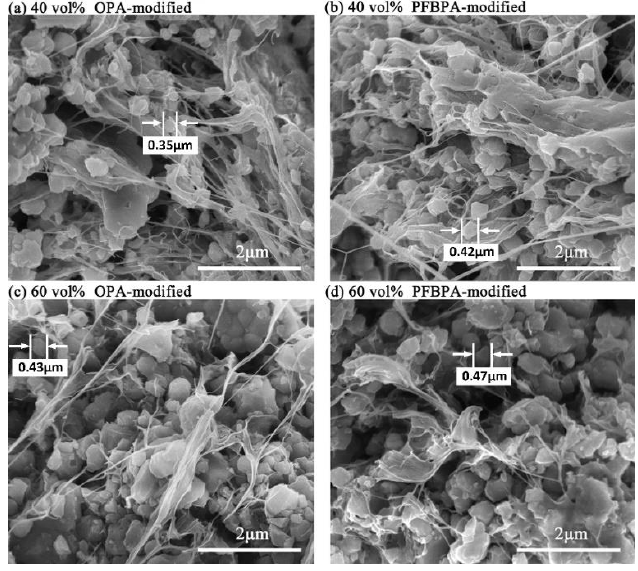
Figure 5. SEM images of freshly fractured cross-sections of Ag/TiO 2 /PTFE nanocomposites containing modified Ag/TiO 2 in loadings of 40 vol % and 60 vol %. ( a , c ): OPA-modified NPs, ( b , d ): PFBPA-modified NPs.